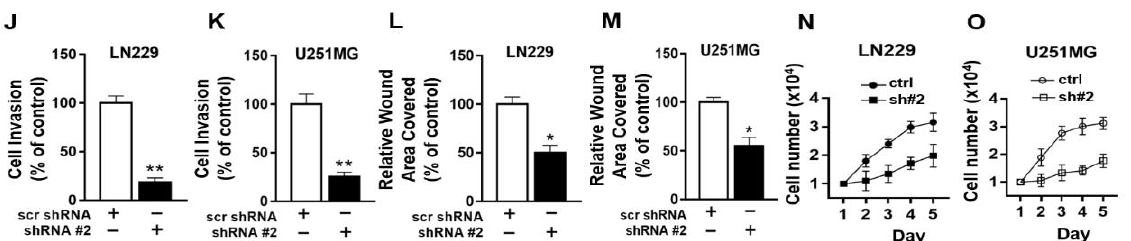
Figure 6. Protein arginine methyltransferase 5 (PRMT5) knockdown inhibits glycolysis, promotes mitochondria function, and decreases invasion and migration in glioblastoma multiforme (GBM) cells. LN229 and U251MG cells were plated on osteopontin (10 µ g/mL) coated plates. PRMT5 knockdown by shRNAs was confirmed and published [24]. ( A , B ) Uptake of glucose analog 2-NBDG was reduced in cells with PRMT5 knockdown. ( C , D ) Lactate levels in culture medium decreased in cells with PRMT5 knockdown. ( E – H ) MitoTracker intensity and cellular oxygen consumption rate (slope) were decreased in cells with PRMT5 knockdown, indicating increased mitochondria function. (400 × for e) ( I – K ) Invasion by Matrigel invasion assays (200 × for I ), ( L , M ) cell migration by wound closure assays, and ( N , O ) cell growth, were decreased in cells with PRMT5 knockdown. All experiments were repeated at least three times. Data are represented as mean ± SE, * p < 0.05, ** p < 0.01.